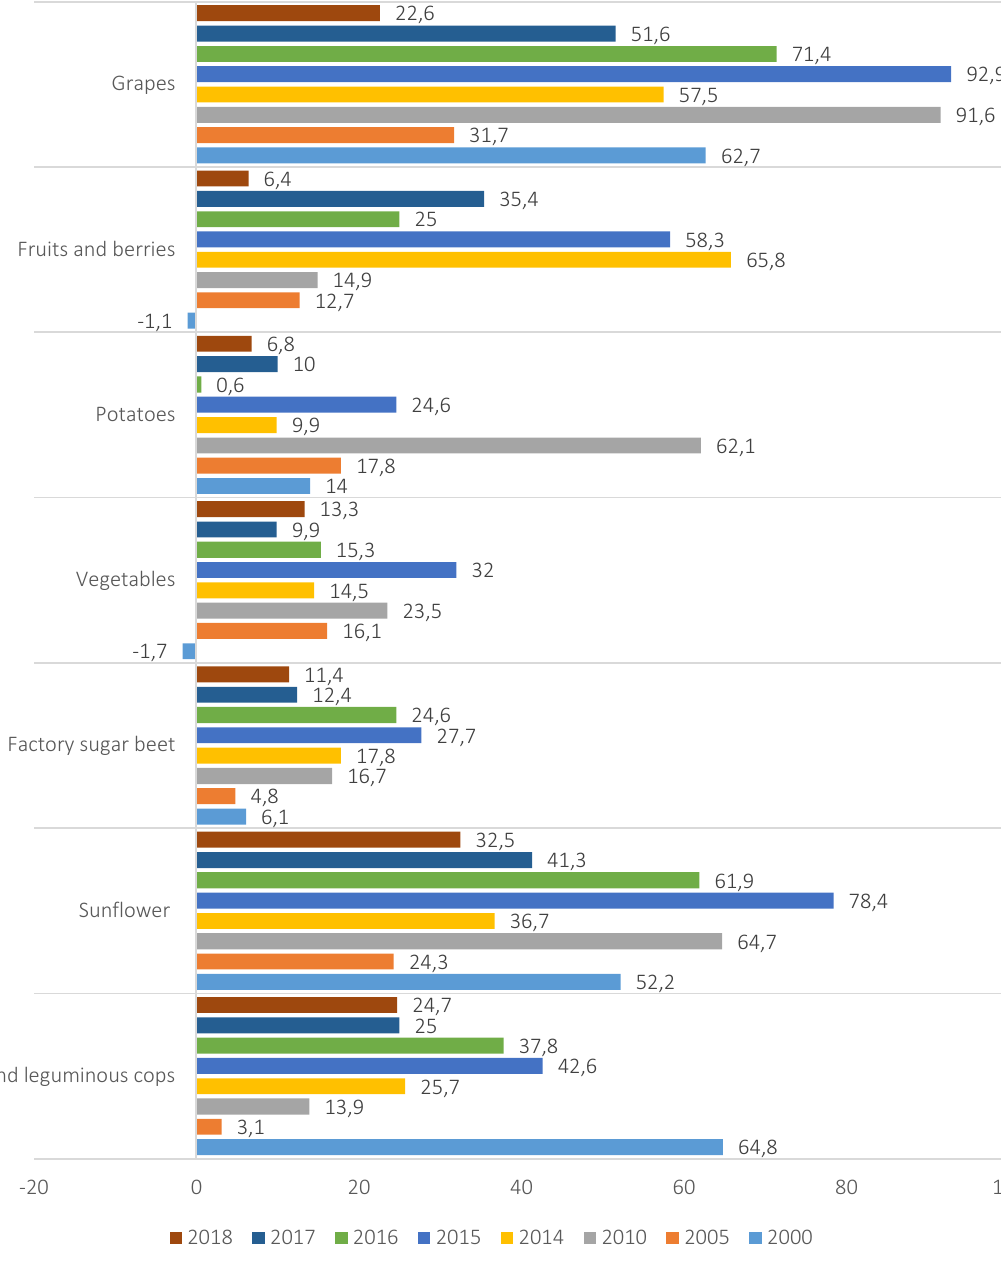
Figure 2. Dynamics of profitability of the main crops in Ukraine,